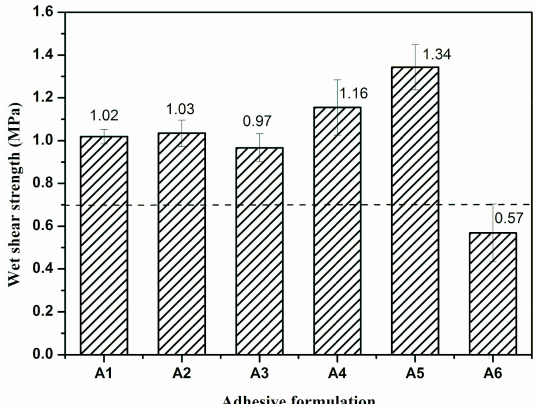
Figure 1. The wet shear strength of plywood bonded by urea formaldehyde (UF) resin with di ff erent fillers: Resin A1—0% SEP + 100% WF, Resin A2—20% SEP + 80% WF, Resin A3—40% SEP + 60% WF, Resin A4—60% SEP + 40% WF, Resin A5—80% SEP + 20% WF, Resin A6—100% SEP + 0%WF. Error bars represent standard deviations from eight replicates.